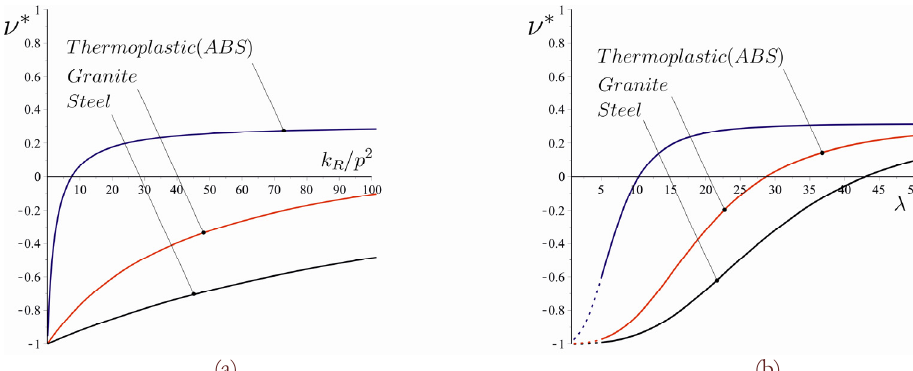
Figure 7: Effective Poisson’s ratio ν * for three different materials in the case of rotational springs. (a) Poisson’s ratio as a function of the stiffness k R /p 2 . (b) Poisson’s ratio as a function of the slenderness λ =p/s.